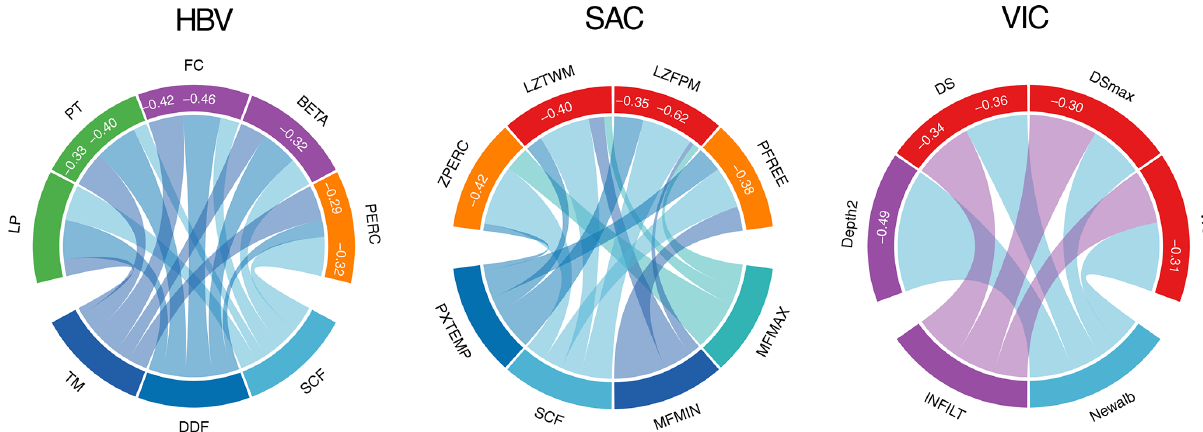
Figure C5. Indication of parameter sensitivity transmission for the discharge timing – the day of the year that half of the discharge has passed. The chord (circle) diagrams display transmission of sensitivity, indicated with a band from the parameter that decreases in sensitivity to the parameter that increases in sensitivity. The width of the band indicates the strength of the negative correlation. The white number indicates the strength of the correlation. In all three chord diagrams, the lower part shows the parameters that decrease in sensitivity and the upper part the parameters that increase in sensitivity, with the white number indicating the strength of the correlation (for clarity, lower negative correlations are not displayed). Colours are according to the process they represent (with different shades of blue used for snow parameters for clarity). The chord diagrams are focused around the most relevant parameters based on Fig.